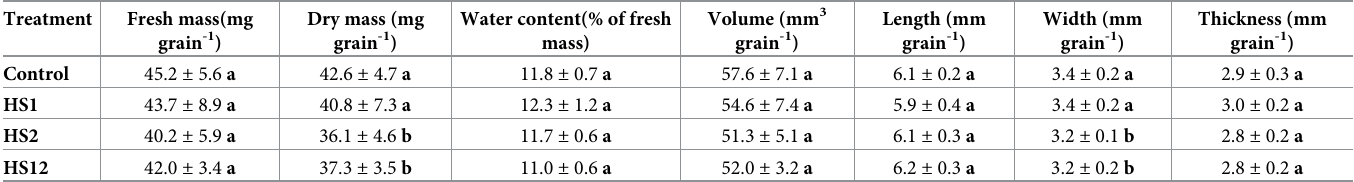
Heat shocks were applied either during the early-phase (HS1), the grain filling phase (HS2) or during both lag- and filling- phases (HS12) of grain development. Data are means ± 1 SD ( n = 5 to 10). Within each column, means followed by different letters are significantly different at the 5% level (SNK